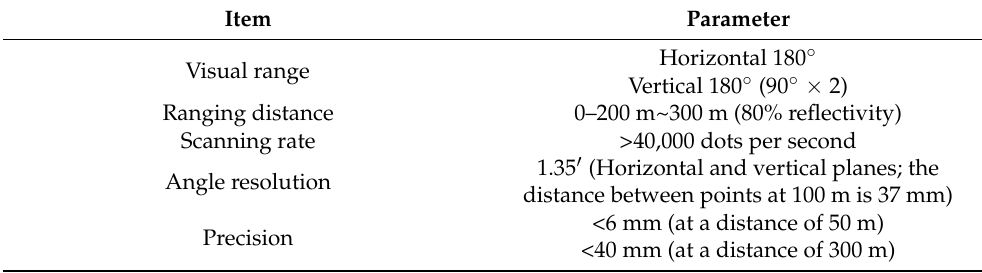
Table 2. Specifications of the X300 laser.